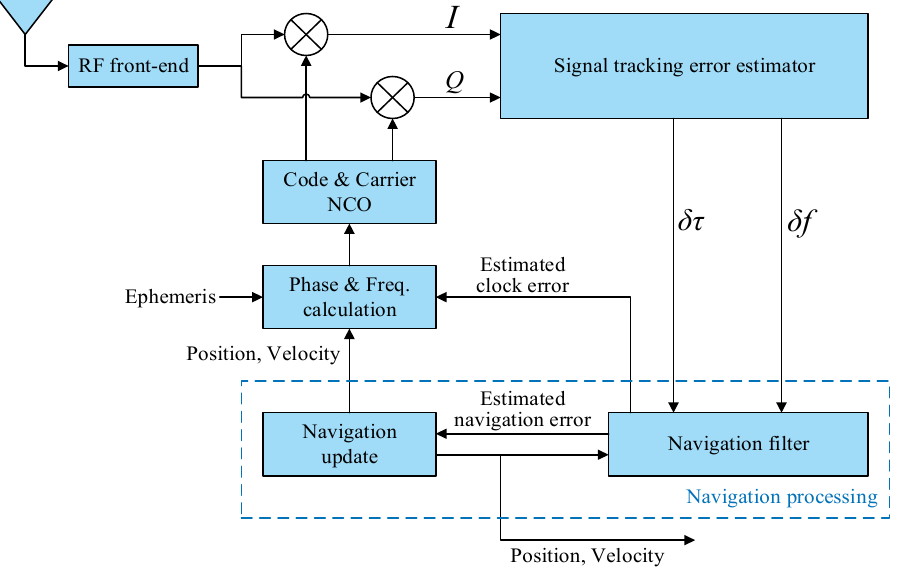
Figure 1. The unified framework of vector tracking loop.